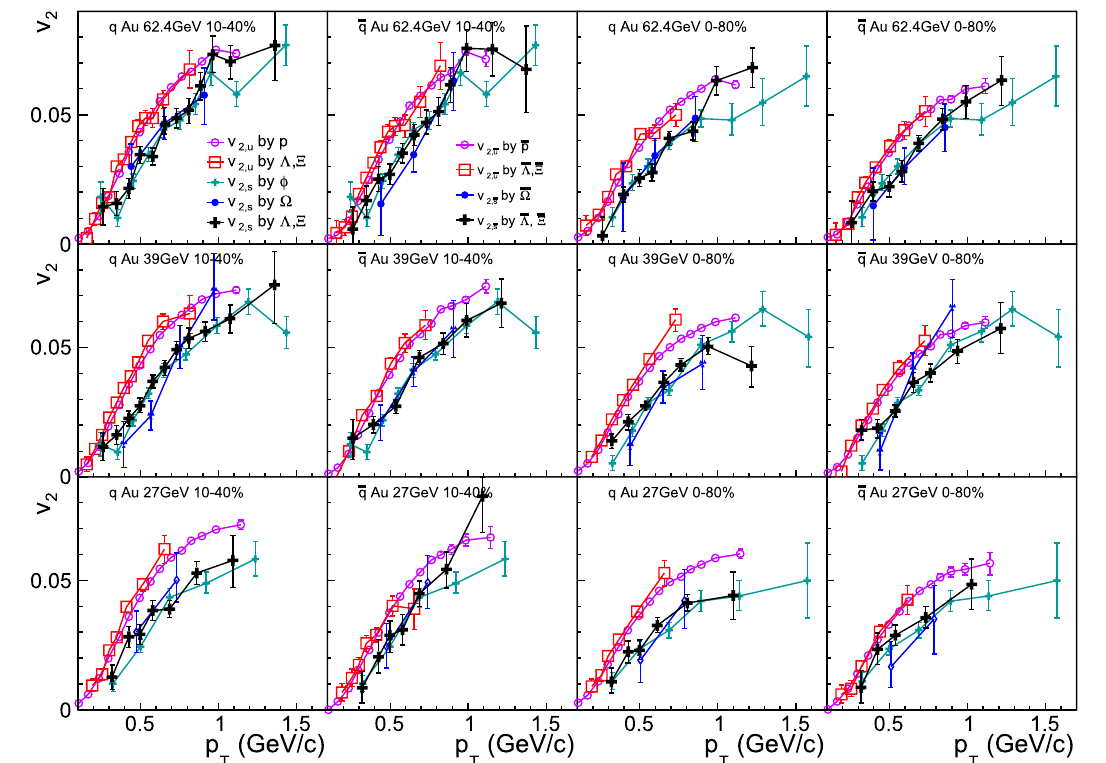
Fig. 2 v 2 , u ( p T ) and v 2 , s ( p T ) extracted from data of identified hadrons in Au+Au collisions in different centralities and at different collision energies [26]